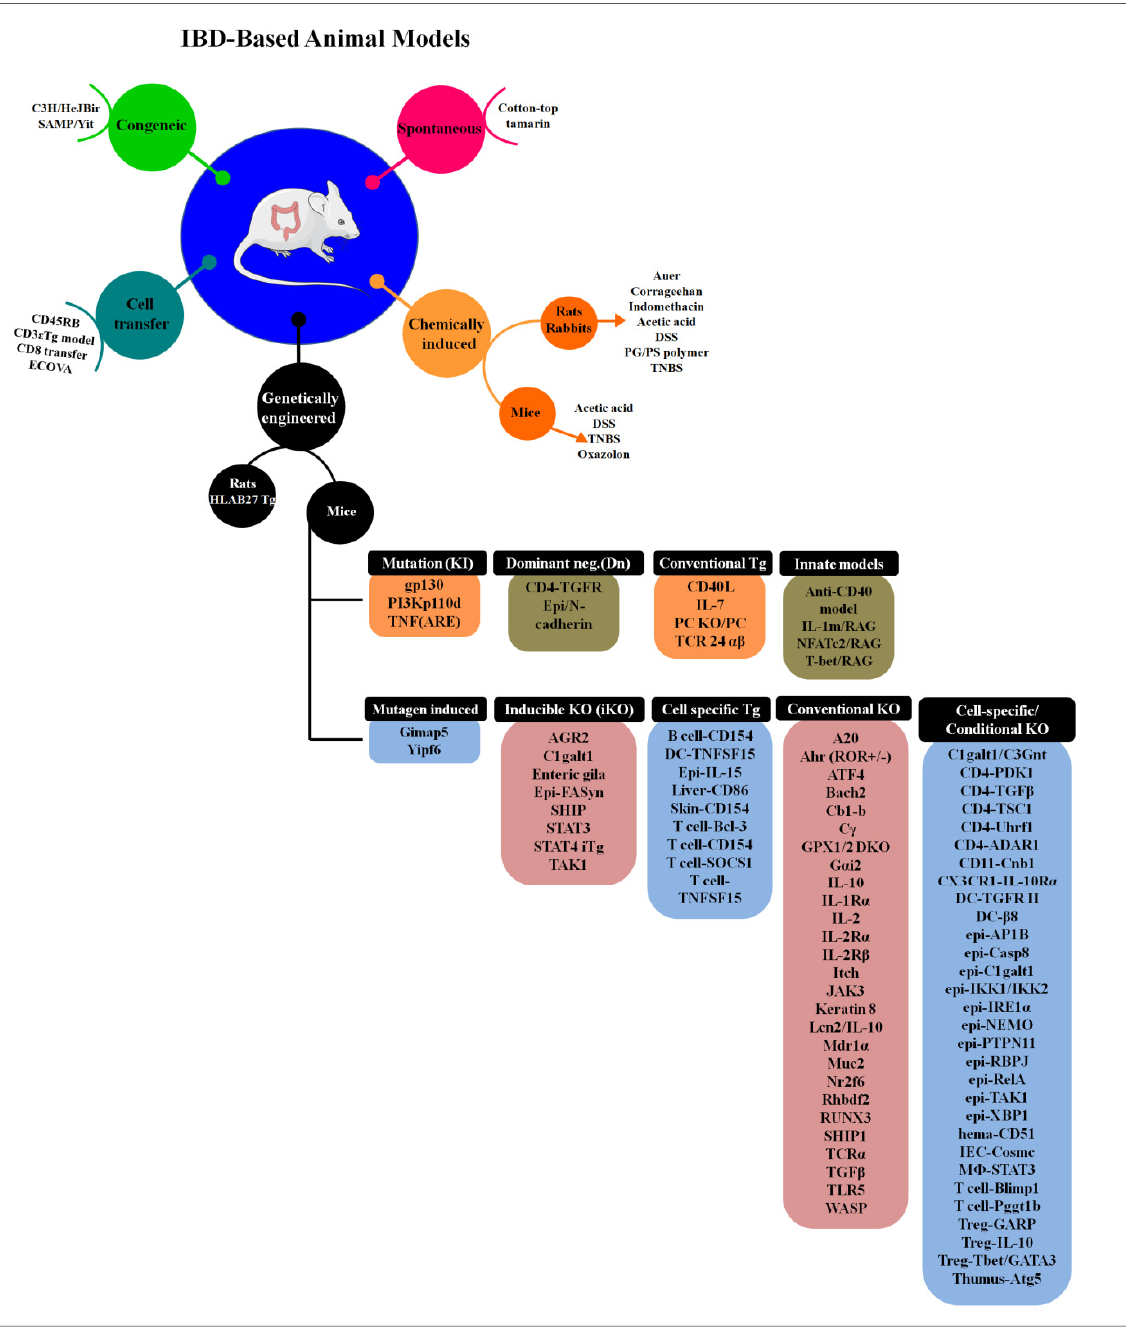
Figure 3. The different types of animal model used to study IBD pathogenesis. In genetically engineered type, different genes are targeting and according to it they are mainly divided into 9 different groups (the detailed information is reviewd in [162]) (adapted and modified from [157,162]).